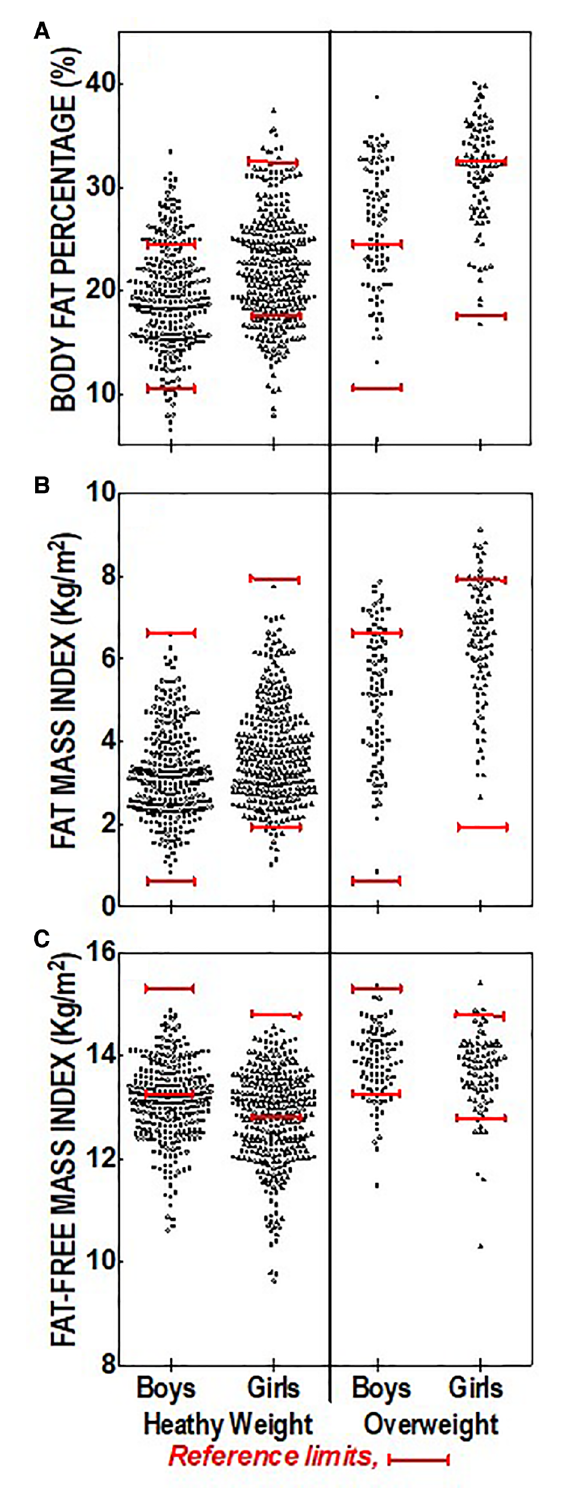
FIGURE 3 Regression analysis and relationships of BMI percentiles versus body composition and indexes with comparisons between boys and girls. ( A ) Signi fi cant correlations for boys ( r =0.91), girls ( r =0.90) and the total group ( r =0.89); ( B ) Signi fi cant correlations for boys ( r =0.93), girls ( r =0.92) and the total group (0.92); ( C ) Signi fi cant correlations for boys ( r =0.82), girls ( r =0.76), and the total group ( r =0.80). Sex slope comparison were signi fi cant for Figures 3A ( p =0.0014) and 3B ( p <0.001) and 3C ( p =0.002).